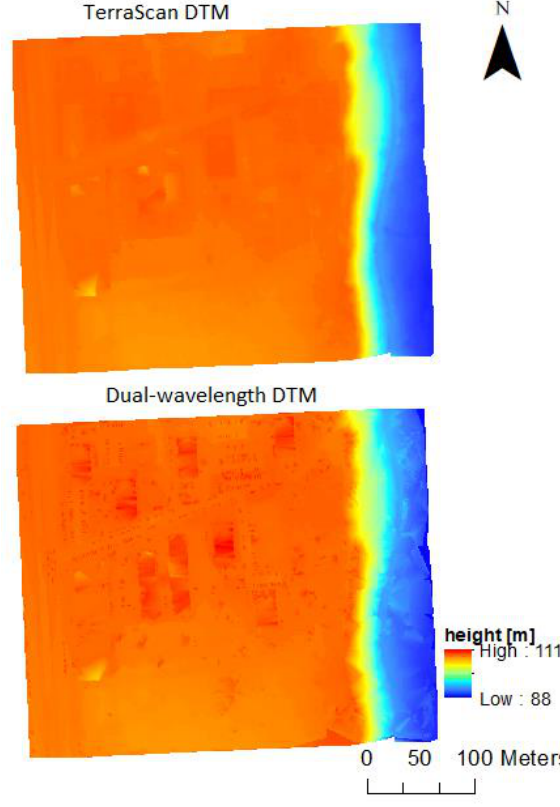
Fig. 6 Comparison of the DTMs generated from the ground class obtained from TerraScan and dual-wavelength